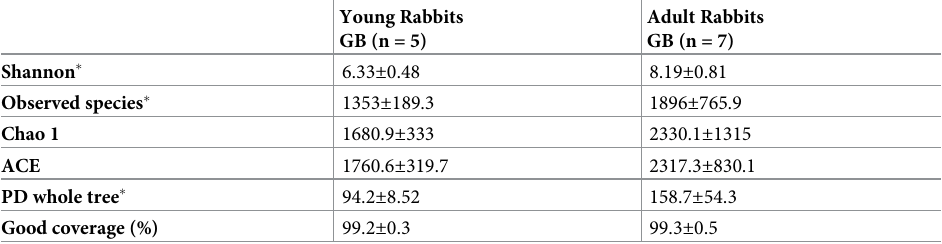
Table 1. Alpha diversity of the gallbladder in rabbits before and after weaning.